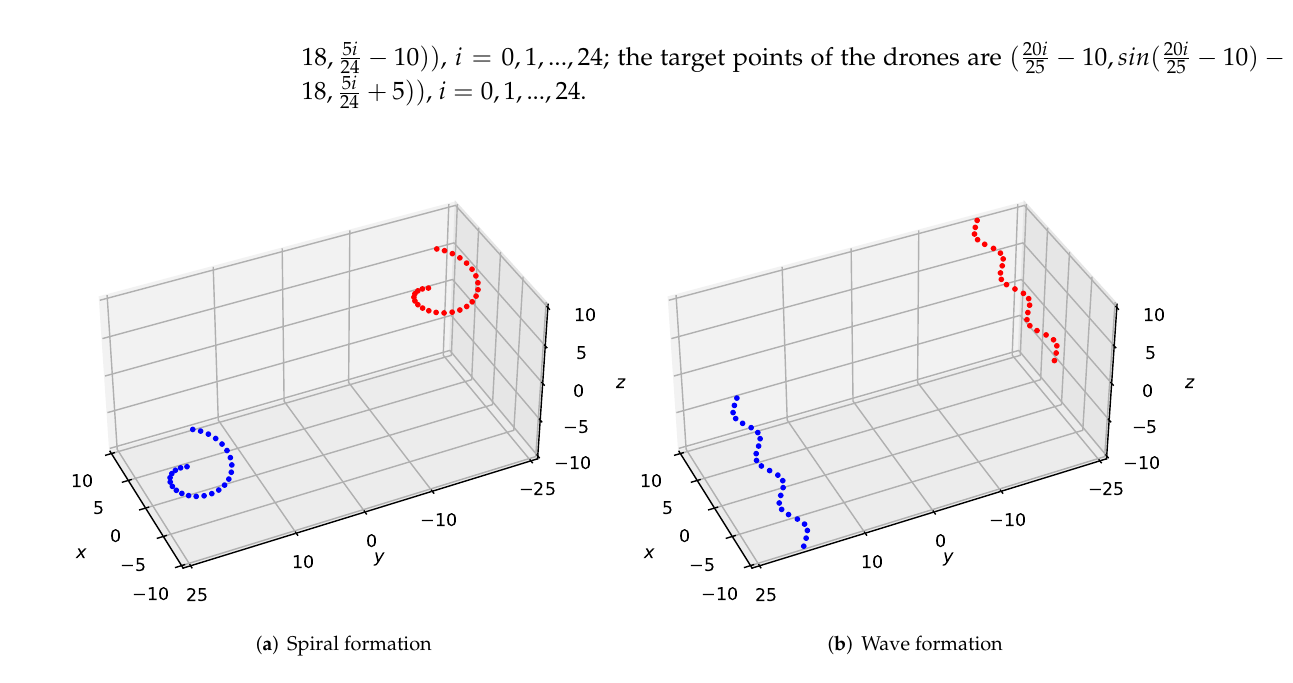
Figure 2. A large-scale desired formation consisting of twenty-five quadrotors traverses a 3-D environment from the bottom left side to the top right side.